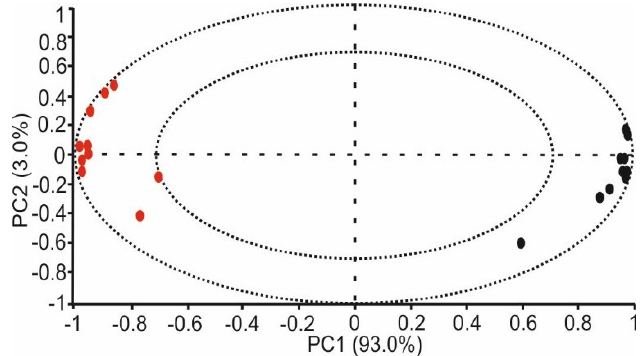
Figure 8. Loading plot of PCA performed from milk samples using the sensor [CHI+IL/CuPc S ] 2 and the biosensor [CHI+IL/CuPc S ] 2 -GAO.